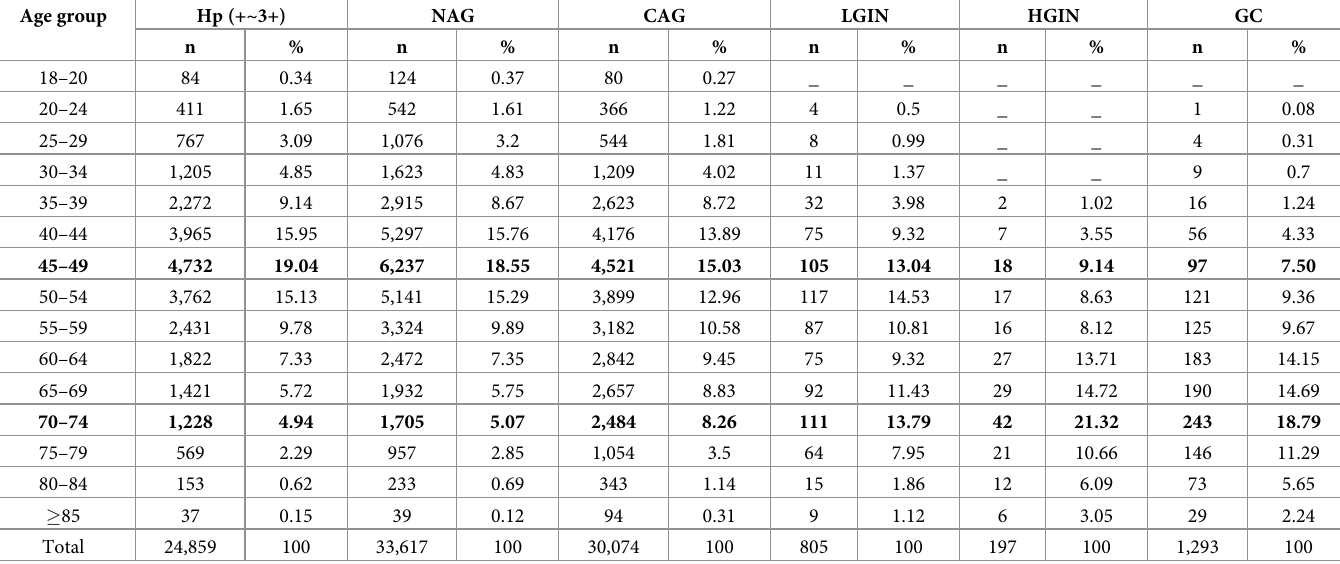
Table 4. Distribution of gastroscopic biopsied patients for Hp infection, gastritis, GIN and gastric cancer by age (years). Age group Hp (+~3+) NAG CAG LGIN HGIN